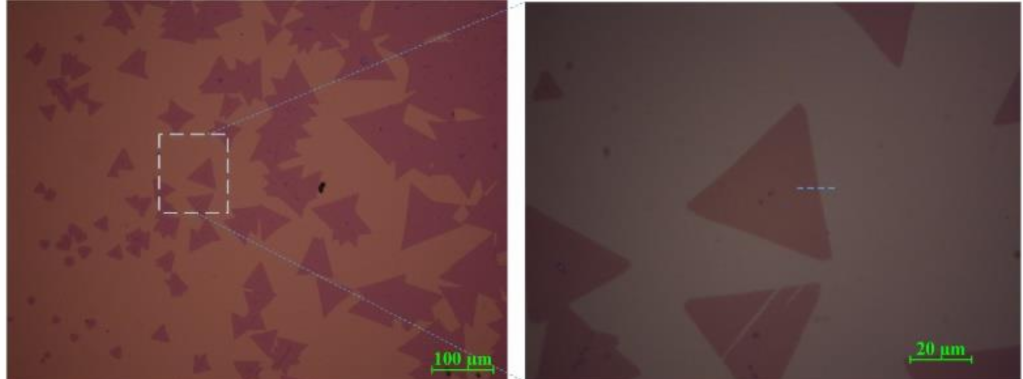
Figure 2. Optical image of MoS 2 crystal on SiO 2 /Si substrate by CVD.